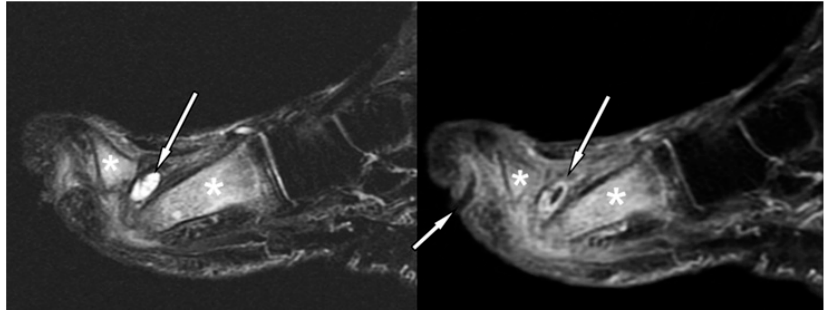
Figure 3. Forefoot ulcer, sinus track, and abscess associated with OM in a 57-year-old diabetic man with a 16-year history of insulin-dependent diabetes. Sagittal T2 fat-suppressed (left panel), and post-contrast T1-weighted fat-suppressed MRI (right panel) shows a dorsal thick rim-enhancing abscess adjacent to the first metatarsal head (arrows). Note a plantar ulcer appearing as a focal skin interruption and a sinus tract with rim-like enhancement (small arrow in right panel) extending near the first proximal interphalangeal joint. Given these findings, the hyperintensity (** in left panel), and post-contrast enhancement (** in right panel) in the first metatarsal, and proximal phalanx respectively, are indicative of